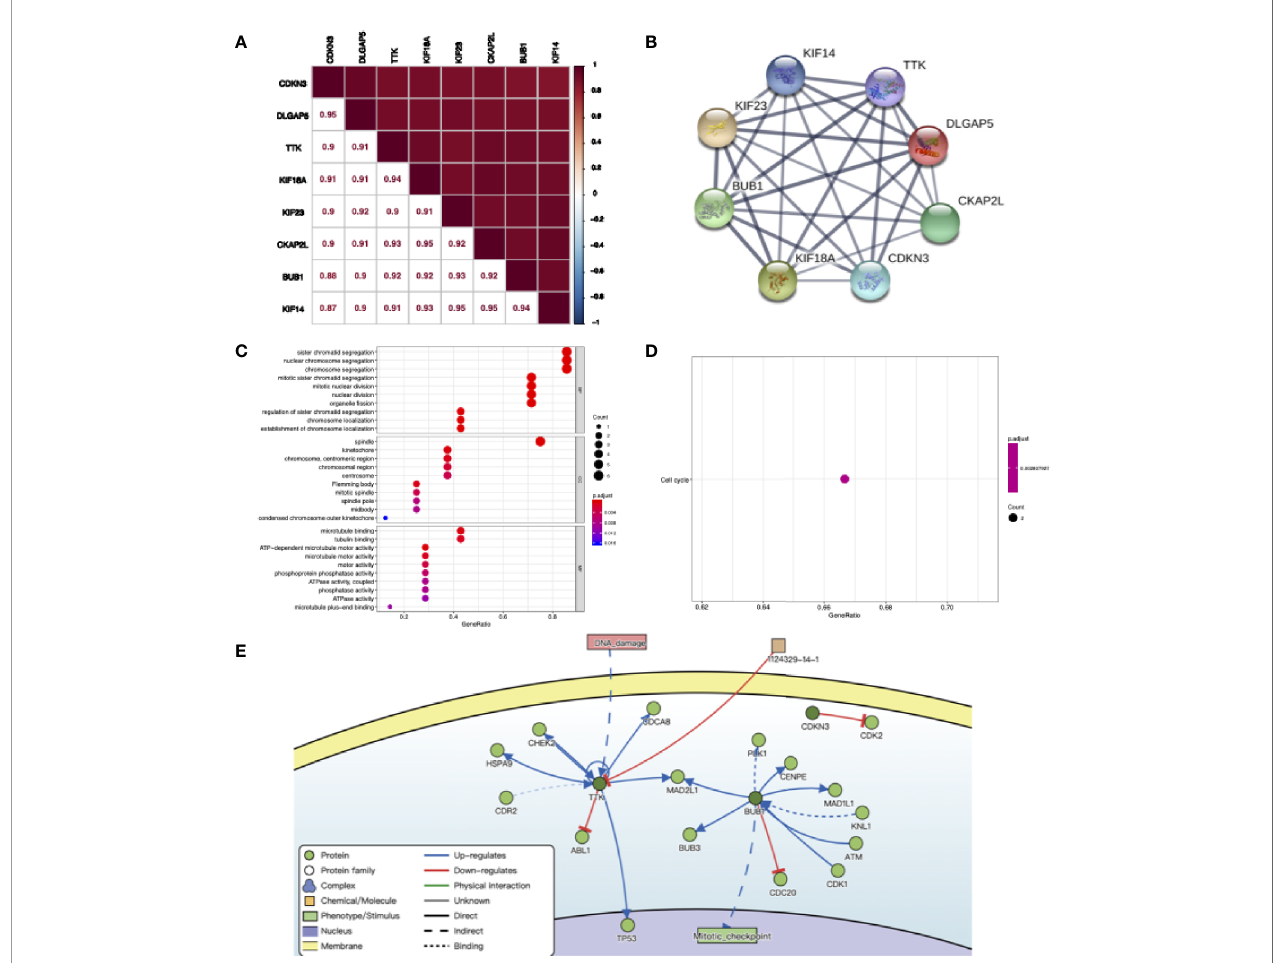
FIGURE 5 | (A) The correlation between co-expression genes of stemness-related genes calculating by RNA-seq data of NJHNCC. Pearson correlation coef fi cient is shown. The depth of square color was determined by the correlation coef fi cient. (B) The relationship of co-expression genes in the STRING database. The thickness of the solid line represents the strength of the correlation. (C) Results for GO enrichment analysis. The color of the dot was determined by P value. (D) Results for KEGG enrichment analysis. The color of the dot was determined by P value. (E) The causal interactions of co-expression genes in DisNor database. The dark green circles represent co-expression genes. The light green circles represent the neighbor of co-expression